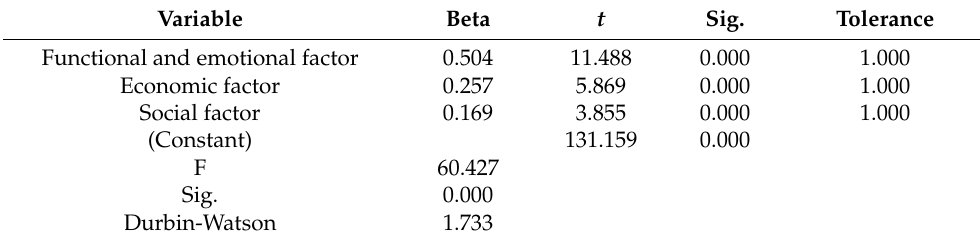
Table 4. Relationship of perceived value and intentions to recommend.